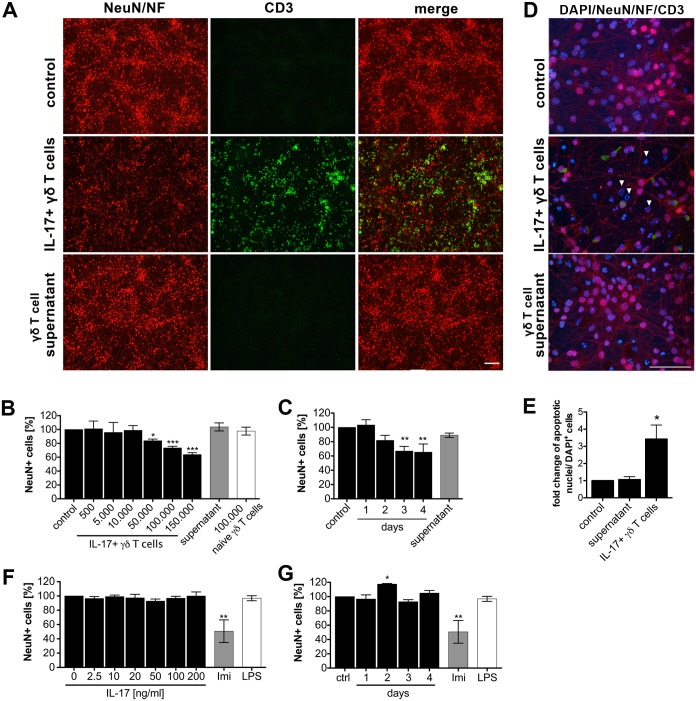
IL-17+ γδ T cells are neurotoxic in vitro.
(A-E) γδ T cells were isolated from C57BL/6J mice and cultured with IL-1β (10 ng/ml), IL-23 (10 ng/ml), anti-CD3 (1μg/ml) and anti-CD28 (10μg/ml) to induce IL-17+ γδ T cells. After 3 days, polarized IL-17+ γδ T cells with their culture media or supernatants only were co-cultured with cortical neurons for 72 h. Neuronal cultures without the addition of γδ T cells served as a control. To evaluate neuronal viability cultures were subsequently immunostained with antibodies against neuronal nuclei (NeuN), neurofilament (NF) to mark neurons (both in red), CD3 to mark γδ T cells (green) and DAPI (blue). Representative images are shown for co-culture with 1x105 polarized γδ T cells after 72 h, in (A) magnification 20x, scalebar 100μm, in (D) magnification 100x, scalebar 50μm, white arrowheads indicate apoptotic nuclei. In (B, C) γδ T cells were isolated, polarized, and co-cultured as described above at indicated concentrations for 72 h or 1x105 polarized γδ T cells were co-cultured for up to 4 days. (E) Quantification of DAPI+ nuclei displaying apoptotic hallmarks. (F, G) Primary cortical neurons were incubated with recombinant IL-17 for 72 h at indicated concentrations or with 50 ng/ml for indicated time points. Neurons treated with imiquimod (10 μg/ml) or LPS (100 ng/ml) served as a positive and negative control, respectively. Cultures were then stained with NeuN Ab and DAPI. Each condition was performed in duplicate and averaged. NeuN-positive cells were quantified and expressed as relative neuronal viability. Mean ± SEM of 3–5 individual experiments, ANOVA with Dunnett´s multiple comparison post test of each time point/condition vs. control, (B) p<0.0001, (C) p = 0.0032, (E) p = 0.0151, (F) p = 0.7851, (G) p = 0.0064.